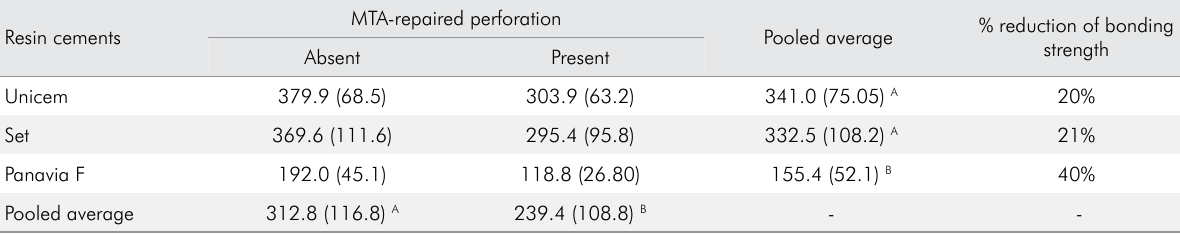
Table 2. Means (standard deviation) of pull-out bond strengths in Newtons. Resin cements